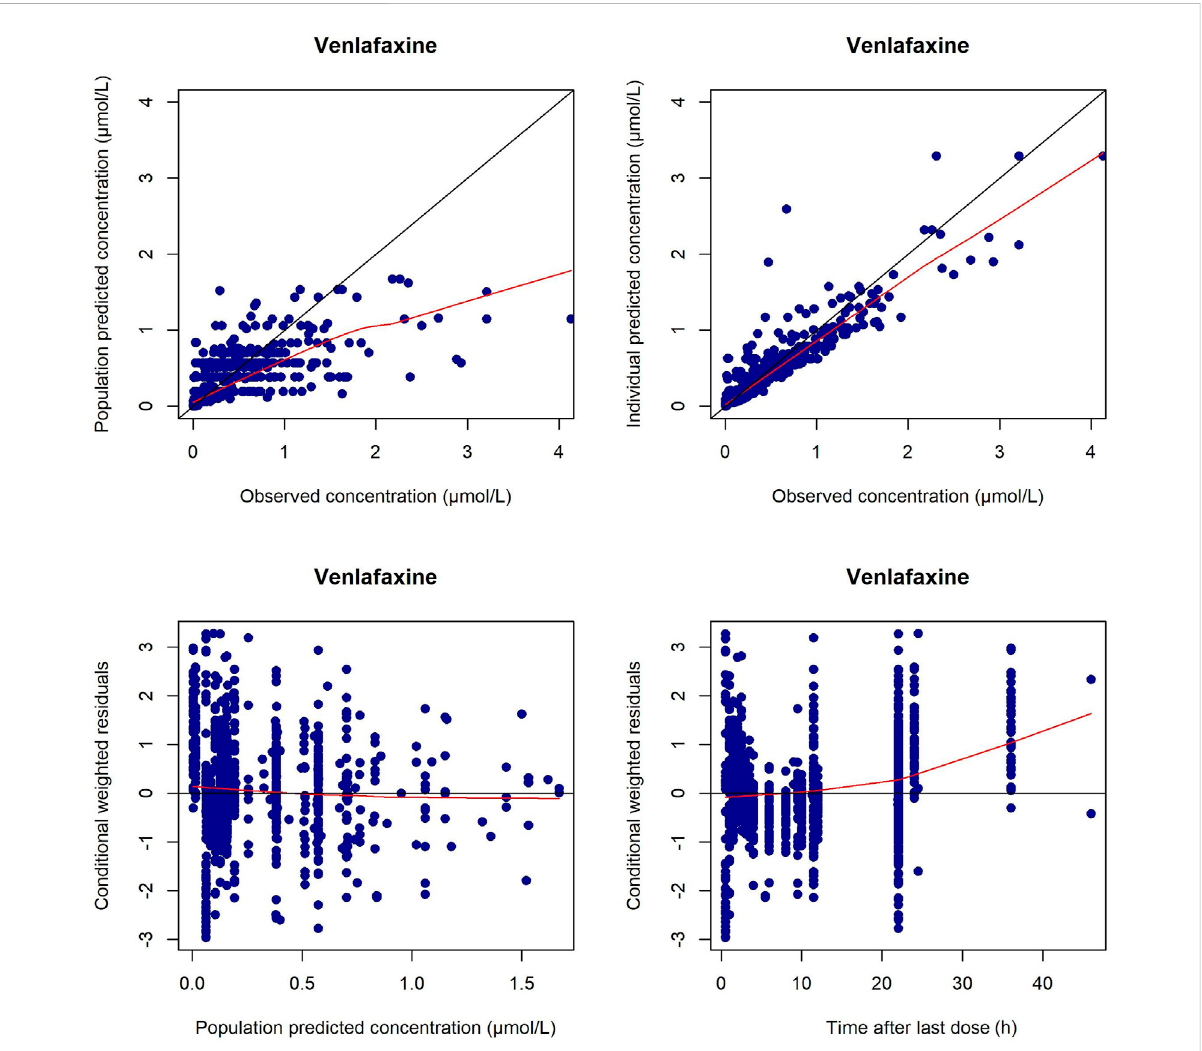
FIGURE 4 Diagnostic plots for VEN in the fi nal PPK model. The left upper is the plot of the population-predicted concentrations versus the observed VEN concentrations; the right upper is the plot of the individual population-predicted concentrations versus the observed VEN concentrations; the left lower represents the conditional weighted residual error versus the population-predicted VEN concentrations; the right lower represents the conditional weighted residual error versus the time after last